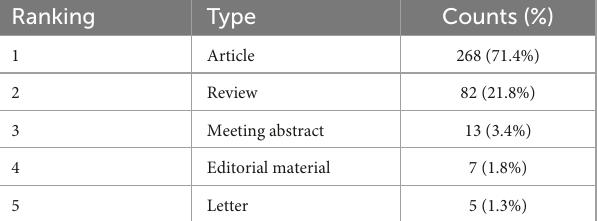
TABLE 2 Document types related to Chinese non-pharmacological therapy on KOA.